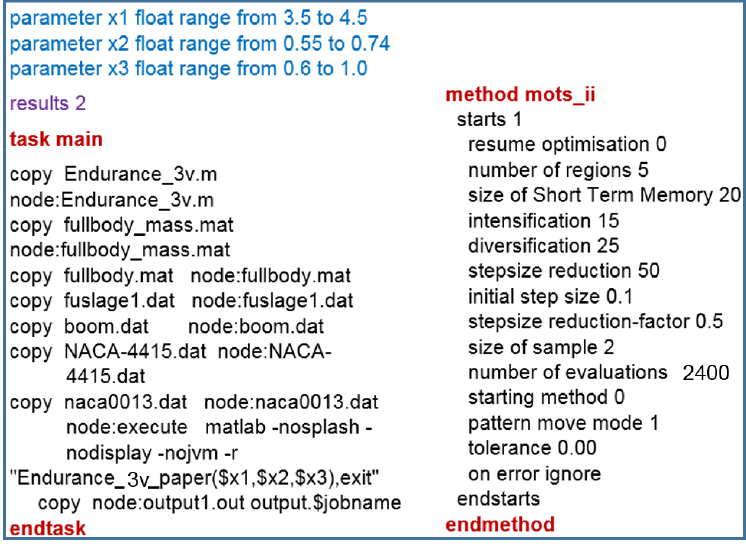
Figure 6. Photograph of model Aegis UAV with U-tail configuration at Cranfield University. The A1 sheet of paper gives an indication of model size.